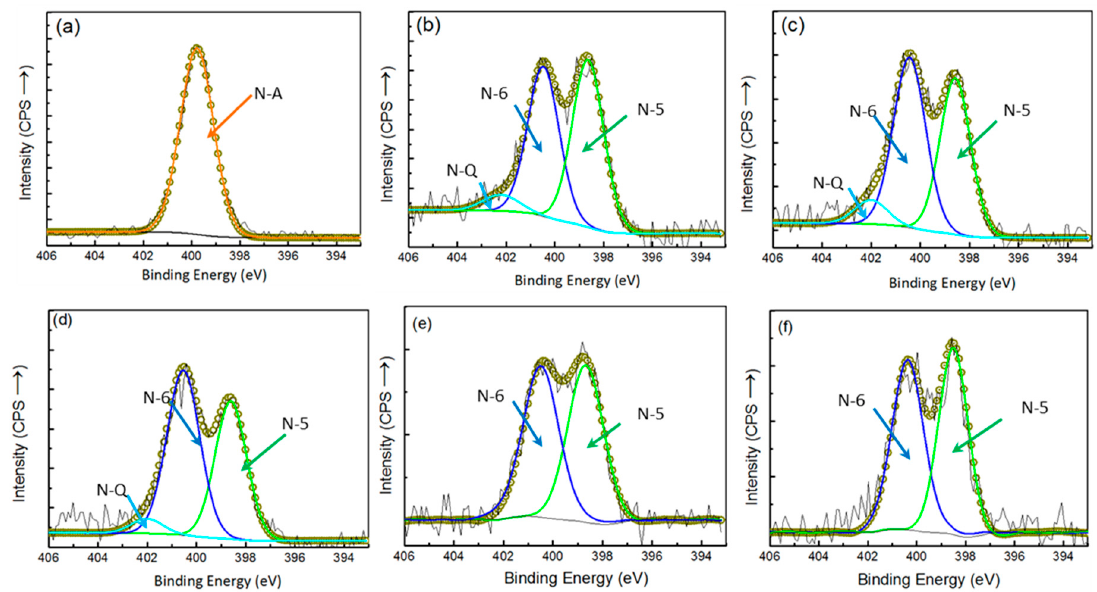
Figure 3. N 1s XPS spectra: ( a ) FB; ( b ) char from FB; ( c ) char from FB with 10% glucose; ( d ) char from FB with 30% glucose; ( e ) char from FB with 50% glucose; ( f ) char from FB with 70% glucose (N-A: Amide-N, N-5: Pyrrole-N, N-6: Pyridine -N, N-Q: Quaternary-N).